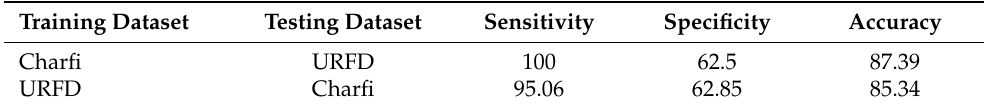
Table 5. Cross data evaluation: Sensitivity, specificity and accuracy using the Charfi dataset to train our algorithm and the URFD dataset as testing and vice